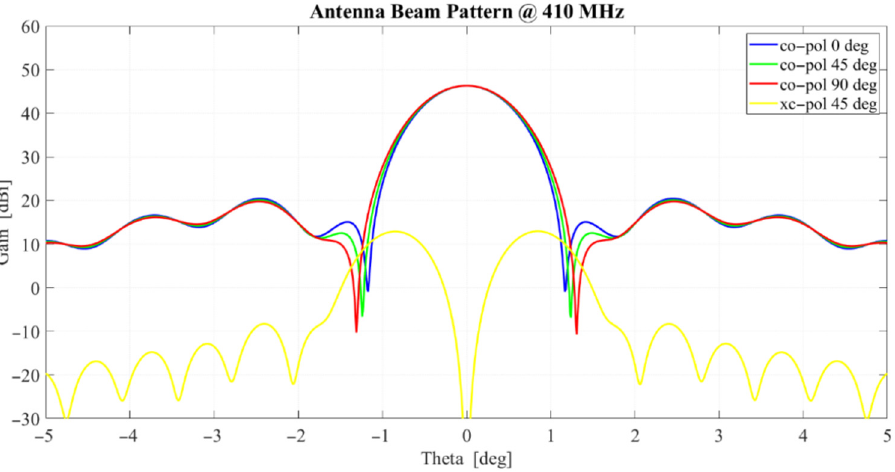
5 of 11 Figure 3. Simulated received power at the antenna (SRT) as a function of the radar cross section (RCS) and range of the object for the Bistatic Radar for Low Earth Orbit (LEO) Tracking (BI- RALET) system.